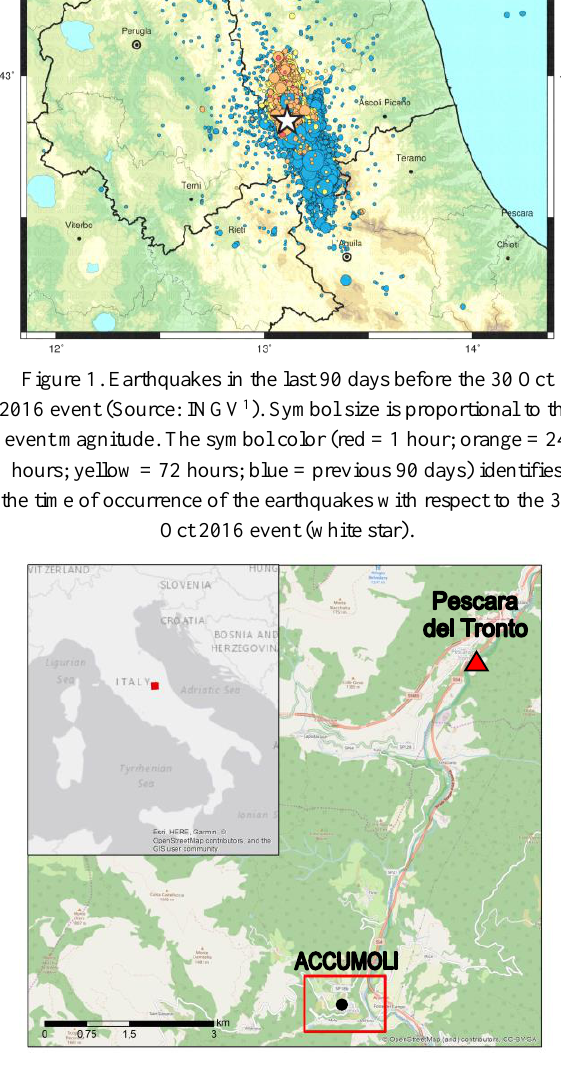
Figure 2. Area of interest covering the Accumoli village (red square)